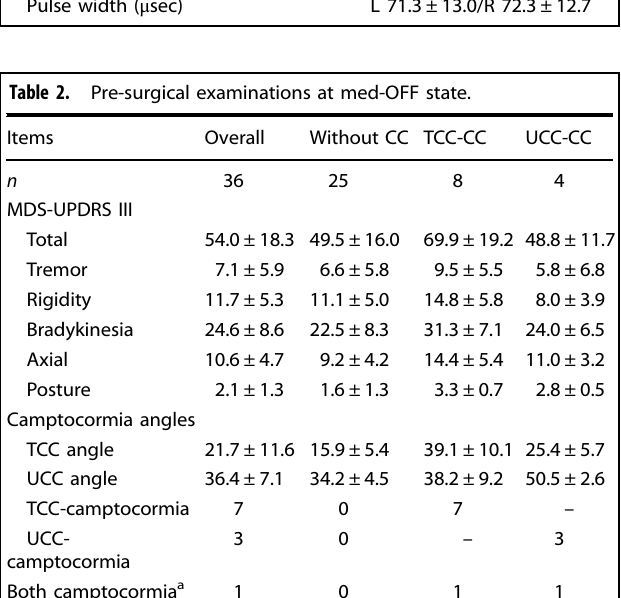
TCC total camptocormia angle, TCC-camptocormia group of patients with a clinically diagnosed camptocormia as de fi ned by a TCC angle ≥ 30°, UCC upper camptocormia angle, UCC-camptocormia group of patients with a clinically diagnosed camptocormia as de fi ned by a UCC angle ≥ 45°. a Both camptocormia means presenting with both TCC- and UCC- camptocormia.